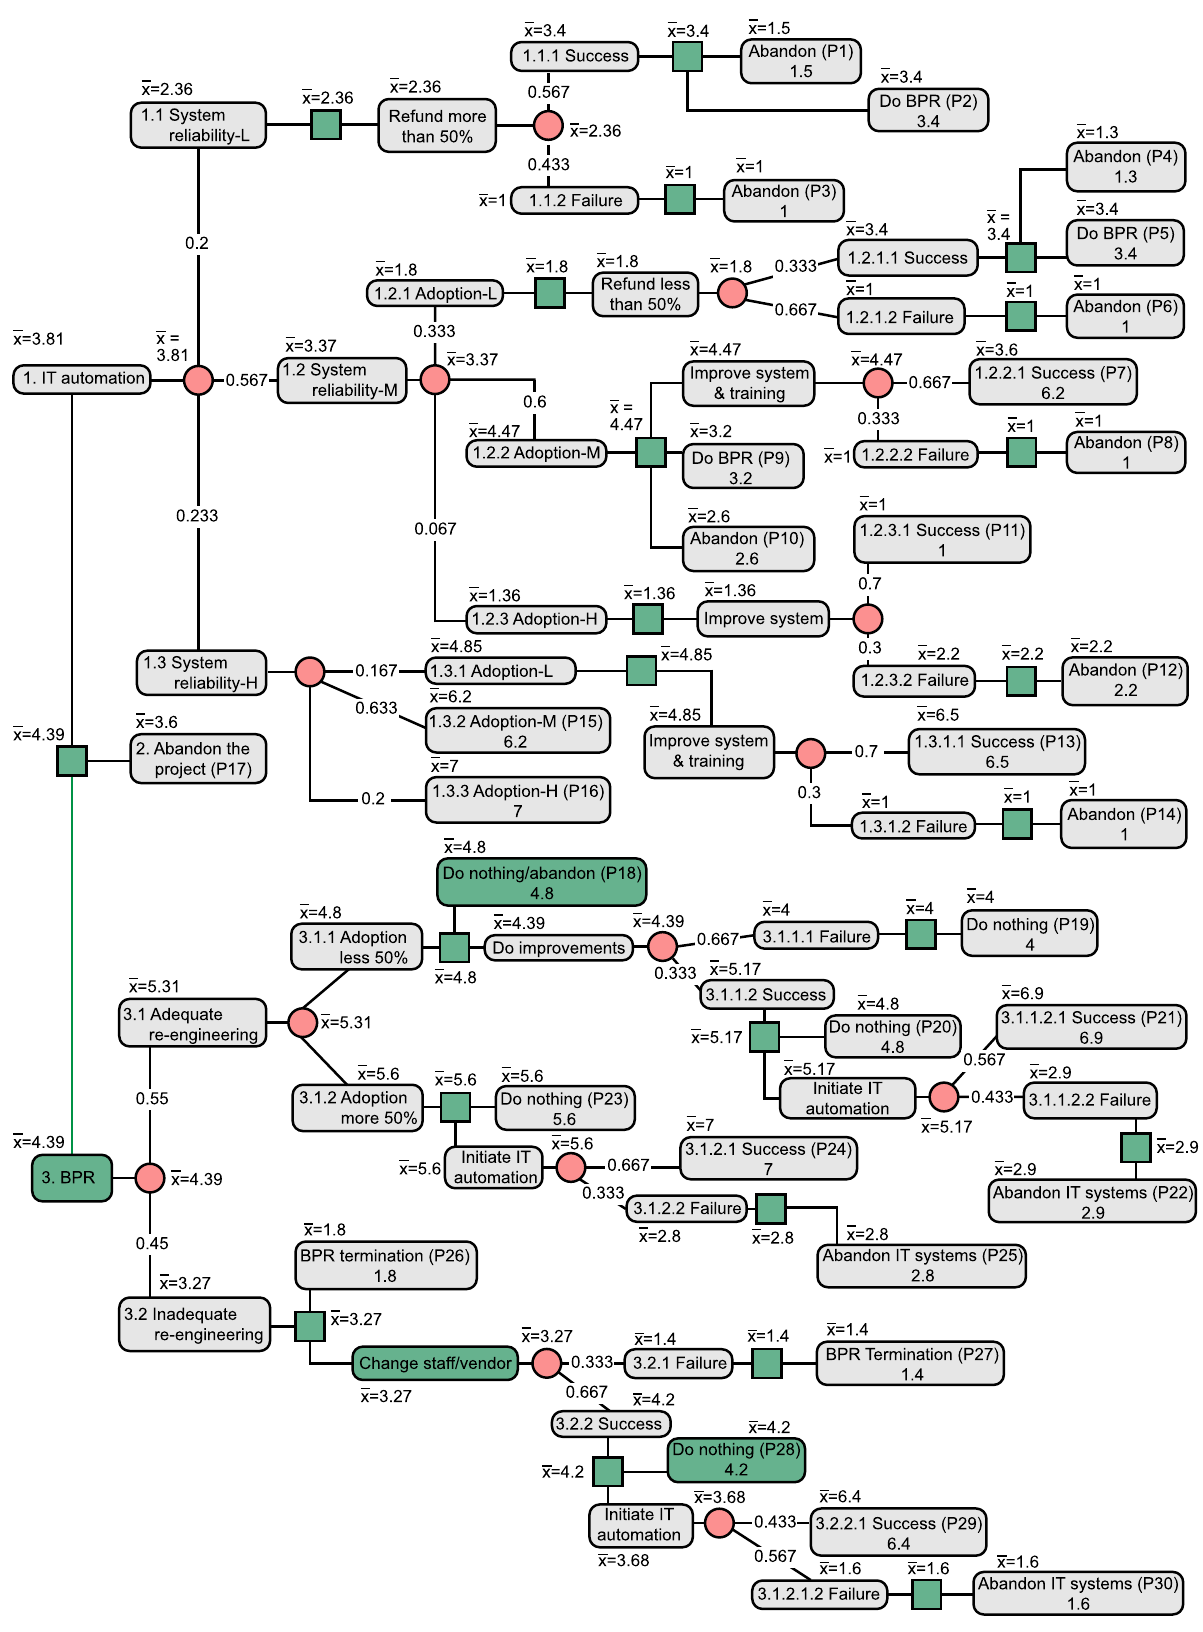
Fig. 2 The decision tree, the final values, and results by maximize SEU in which Expected Value (EV) =